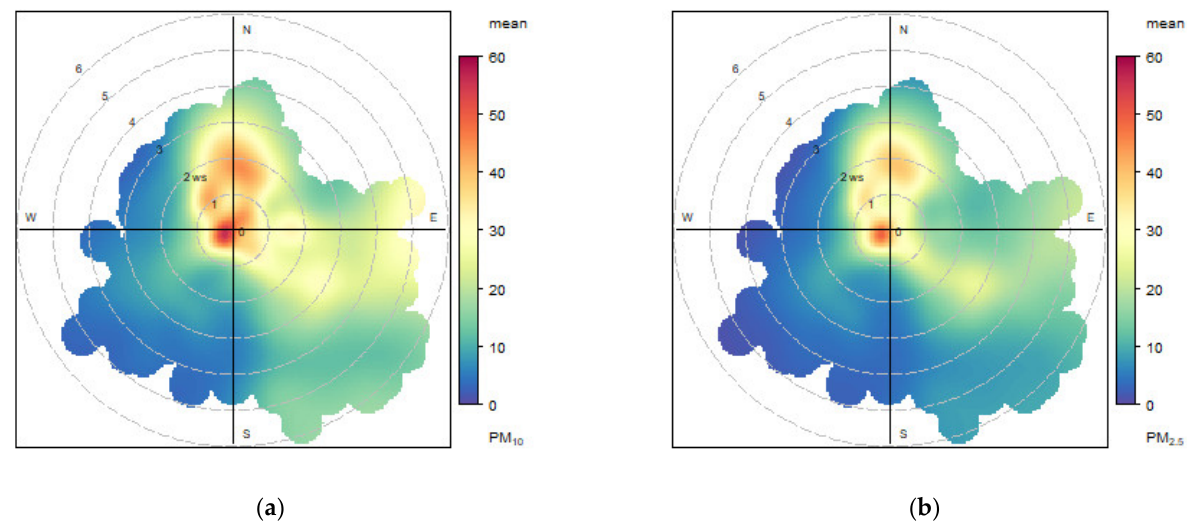
Figure 3. PM 10 pollution rose ( a ); PM 2.5 pollution rose ( b ) at AQM Třinec-Kanada in 2017 (data CHMI [52,53]).